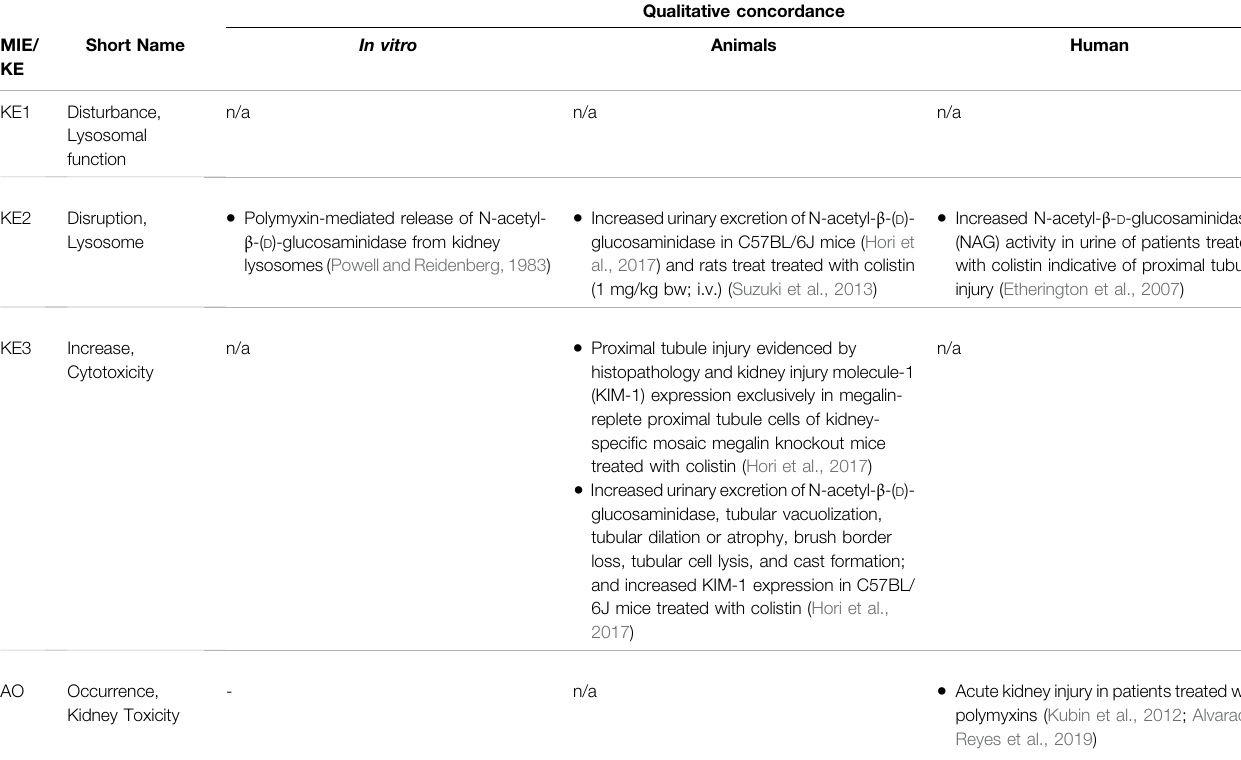
TABLE 4B| Evidence from human, animaland in vitro studies on polymyxins supportingthe keyevents and qualitative concordance of KEs within thisAOP (n/a = notdata